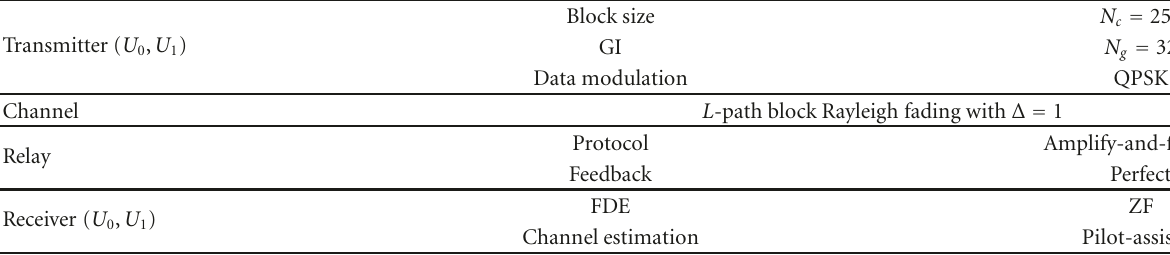
Table 1: Simulation parameters.